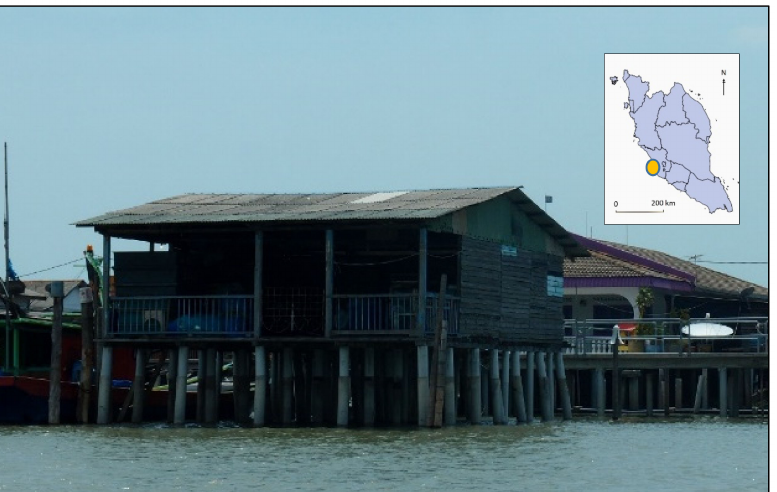
Figure 20. Community adaptation with an increased level of the house pillar, Klang [137]. Reprinted from Impact of Sea Level Rise Due to Climate Change: Case Study of Klang and Kuala Langat Districts, 2018; open access publication by IJET